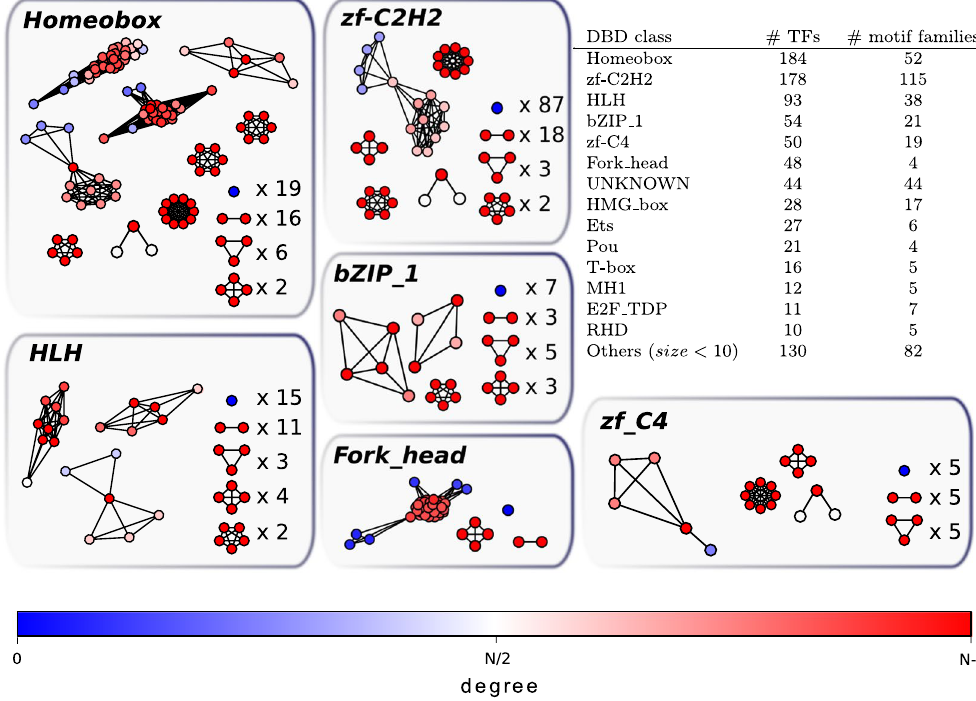
Figure 1. Graphical representation of motif families. The table summarizes the organization of the DBD families in motif families. Each vertex is a transcription factor, while links connect two TFs if they share at least one Position Weight Matrix ID. Colors identify the node degree with a color code (reported in the legend) spanning from blue, corresponding to degree 0 (isolated nodes), to red, corresponding to the maximal degree, i.e., the vertex is connected to all other nodes in the family. The circular layout highlights those families that are cliques. See Supplementary Material for reference to detailed family composition.